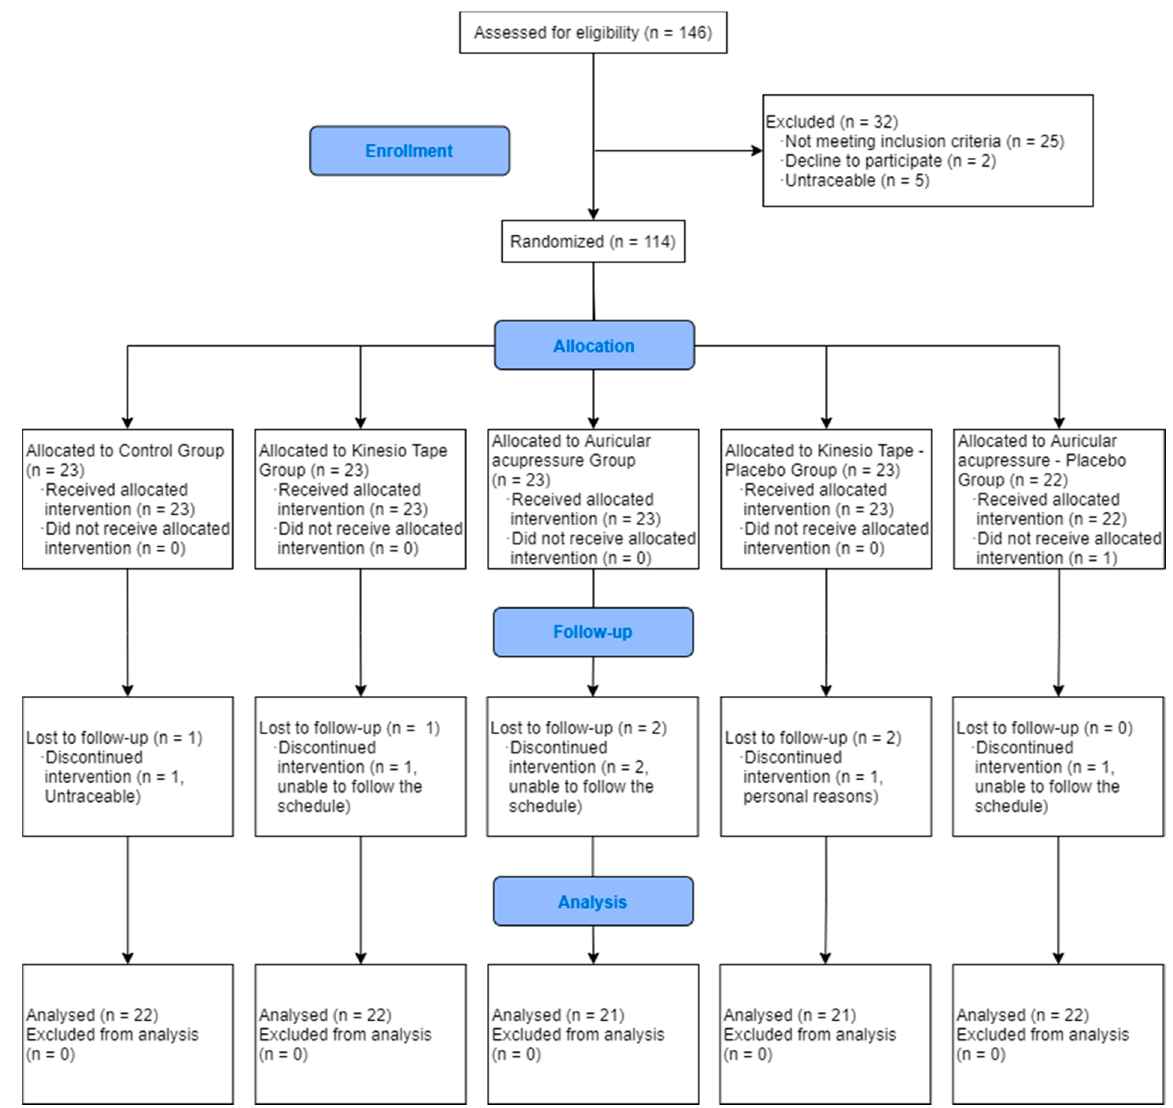
Figure 1. CONSORT flow diagram.